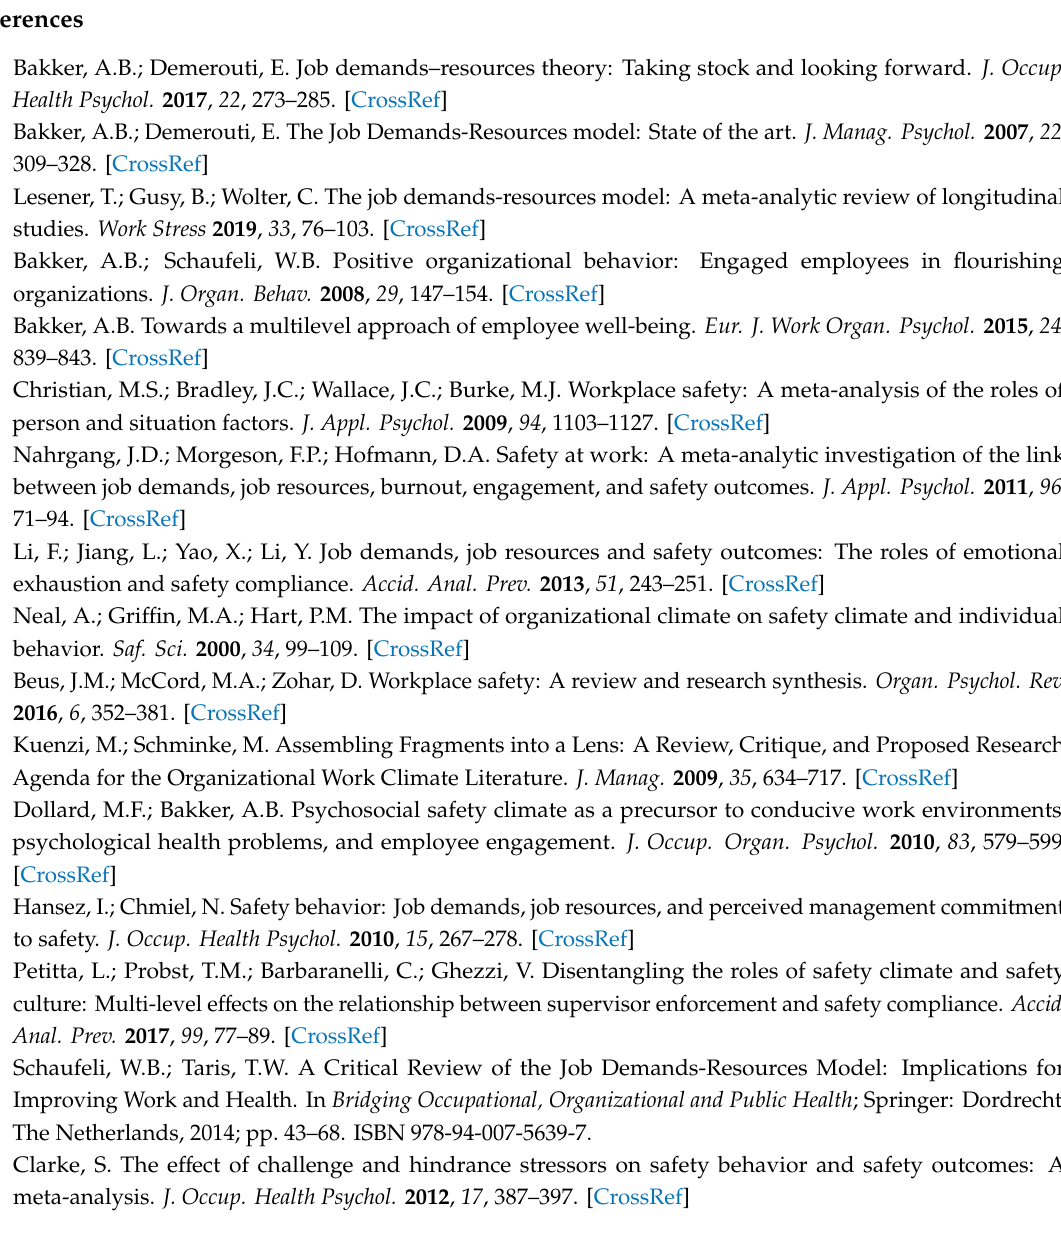
Figure S1: Flow Chart of the Study Process, Table S1: List of Items Used for The Study